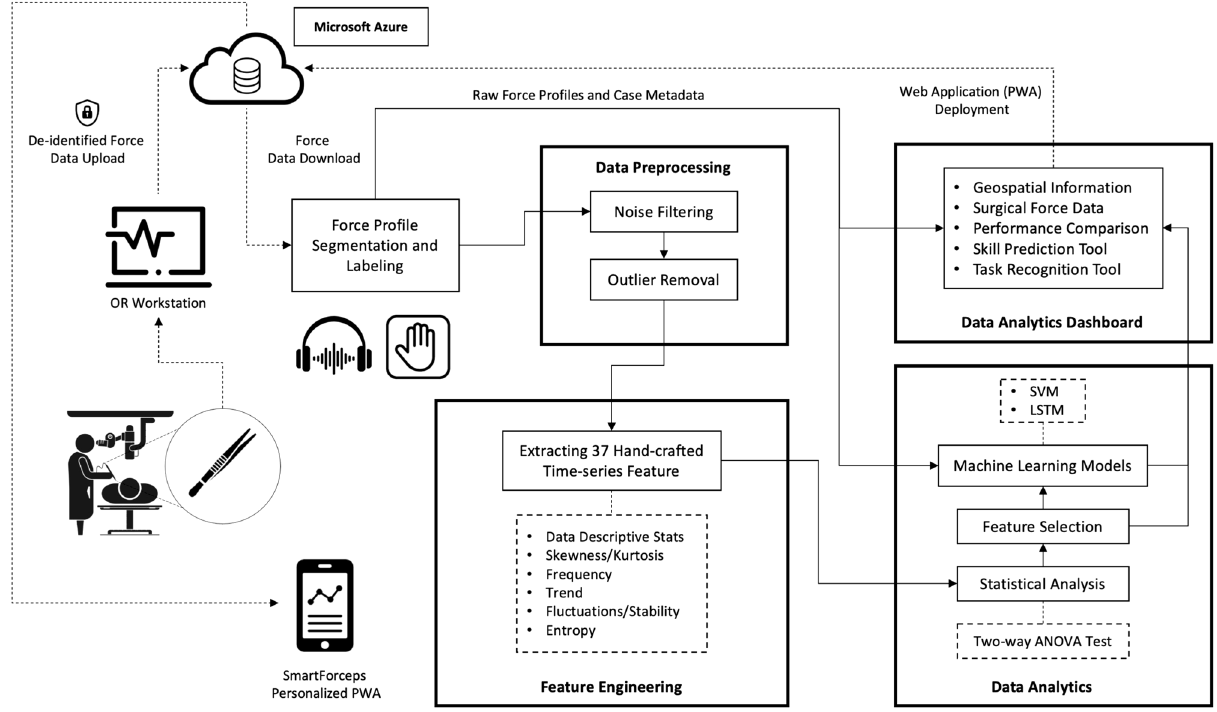
Figure 7. Workflow diagram of SmartForceps data management and analysis pipeline. Forces of tool-tissue interaction along with de-identified case information is uploaded to a HIPAA-compliant data storage and analytics architecture, i.e., Microsoft Azure. Force data were manually segmented and labelled by listening to the operating room voice recordings where each surgeon name, surgical tasks, and important incidents were properly narrated. Data Pre-processing was performed for noise filtering (Butterworth low-pass filter) and outlier removal (1st and 99th percentiles of either maximum force, minimum force, or task completion time). To generate a holistic information from tool-tissue interaction force profiles, 37 hand-crafted time-series features were extracted in Feature Engineering phase. In Data Analytics phase, two-way ANOVA tests were examined to monitor the representation power of each feature set for different surgeon skill and task categories and a subset of 25 features was selected. The force profiles and selected features were used in Data Analytics Dashboard for performance monitoring and machine learning modelling tools to perform skill prediction and task recognition. The visualization was created in Microsoft PowerPoint version 16.49 with the icons obtained from a Google search: e.g., https:// www. iconfi nder.